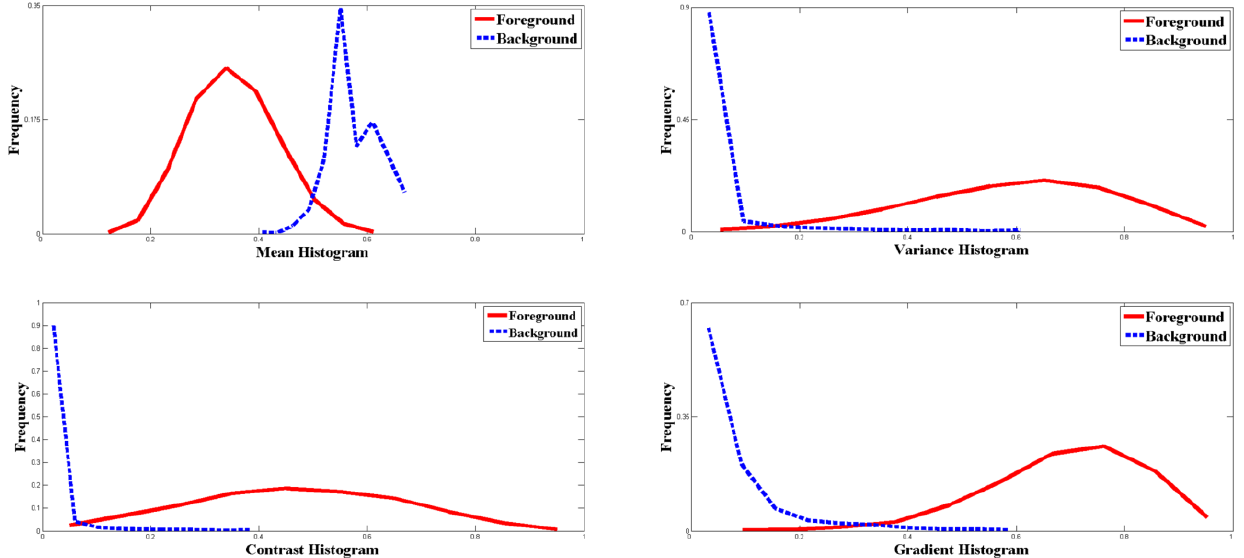
Figure 1. Features’ histograms of 10 fingerprints in FVC2000